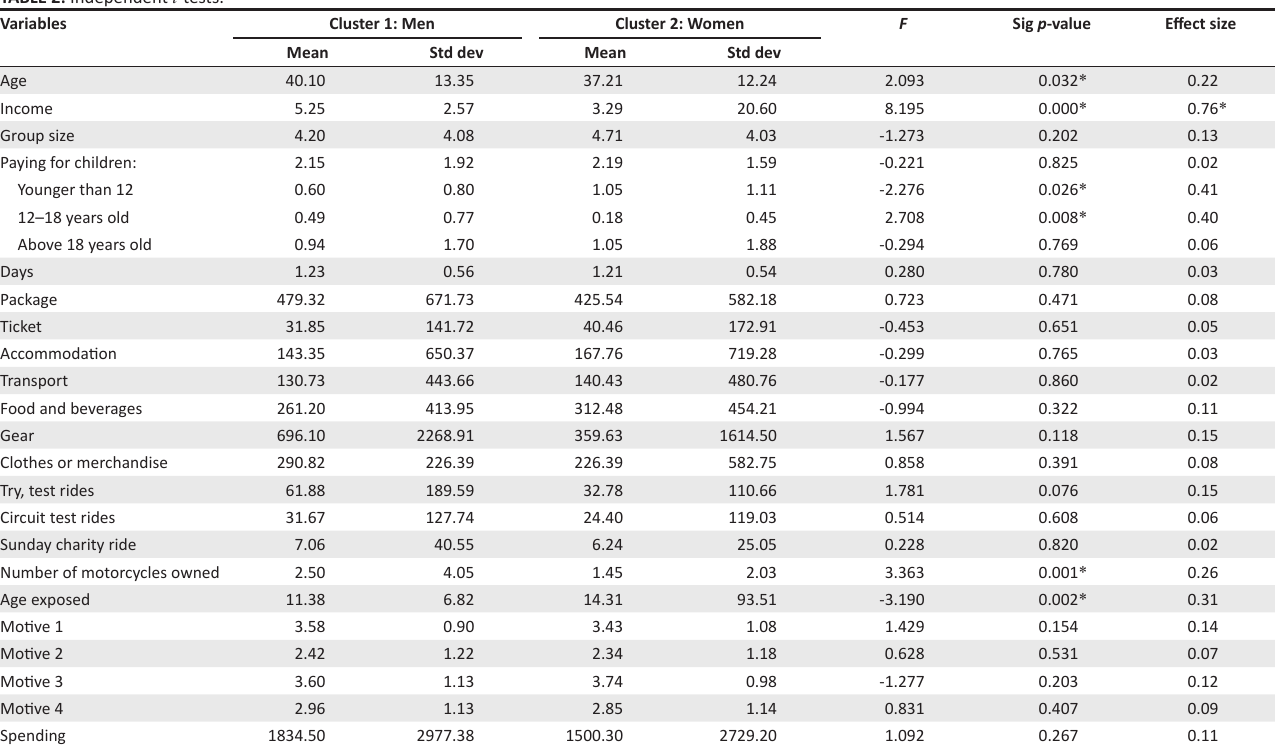
TABLE 2: Independent t